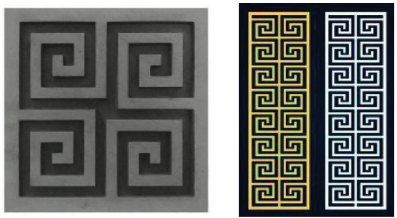
Figure 1: “ 回 ” word pattern structure.